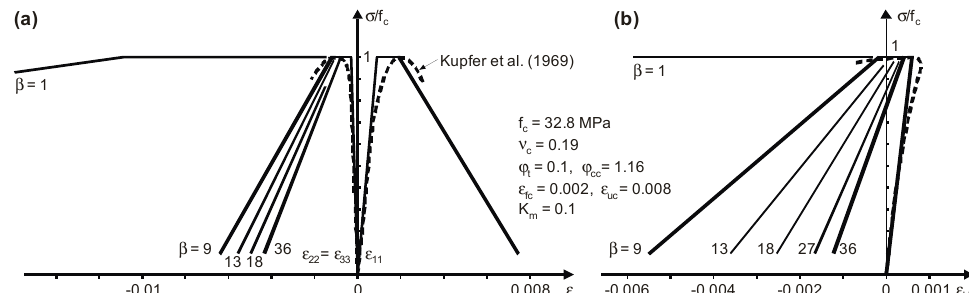
with solid lines, while the experimental curves according to [1] were marked with dashed lines. In Figure 5a, the variation of stress as a function of strain 𝜀 (cid:2869)(cid:2869) “forcing” the considered stress state and as a function of transverse strains 𝜀 (cid:2870)(cid:2870) = 𝜀 (cid:2871)(cid:2871) resulting from volumetric strains 𝜀 (cid:2868) = (cid:2869) presented for different 𝛽 values in the plastic potential function (Equation (16)). Graphs of stress changes as a function of strains 𝜀 (cid:3038)(cid:3038) are shown in Figure 5b. The result for 𝛽 = 1 corresponds to the solution obtained for the associated flow rule 𝐺 = 𝐹 .